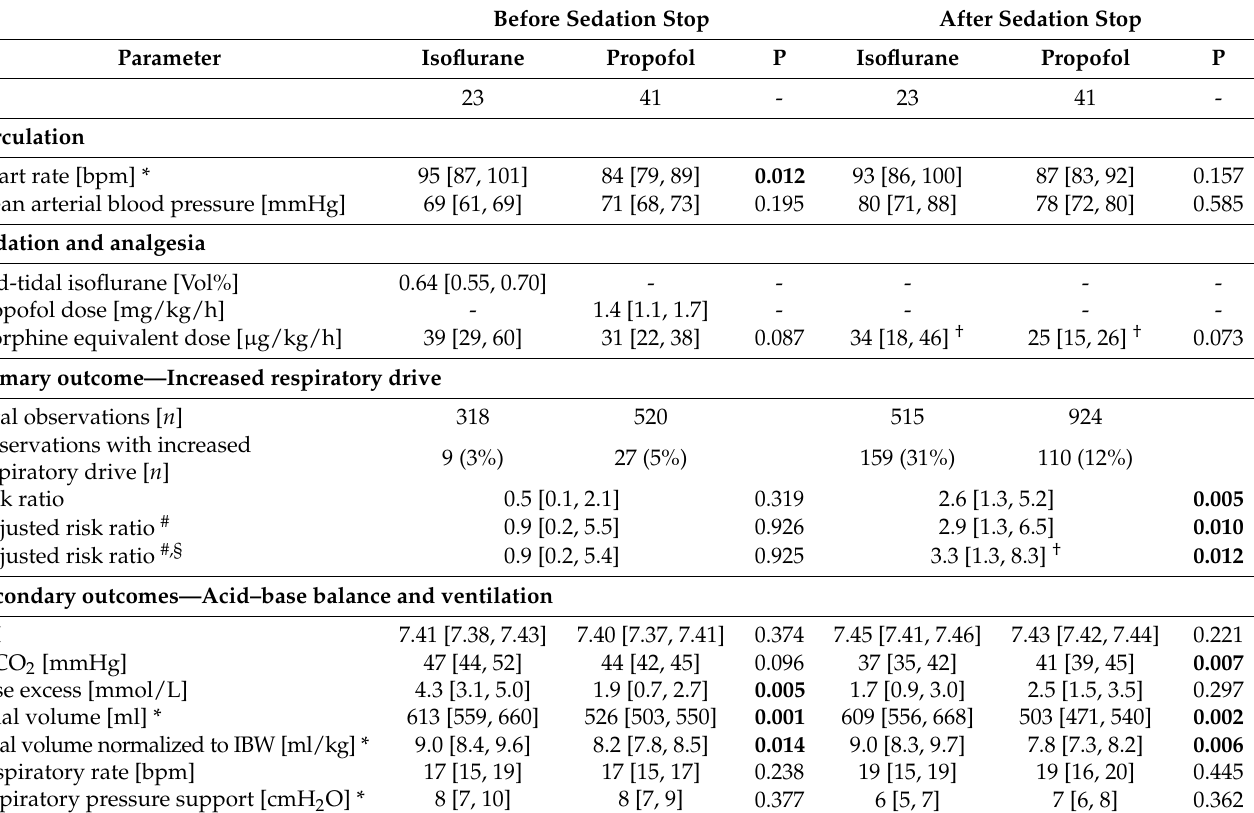
Table 2. Circulatory and ventilatory measures within 48 h before and 72 h after sedation stop. Before Sedation Stop After Sedation Stop